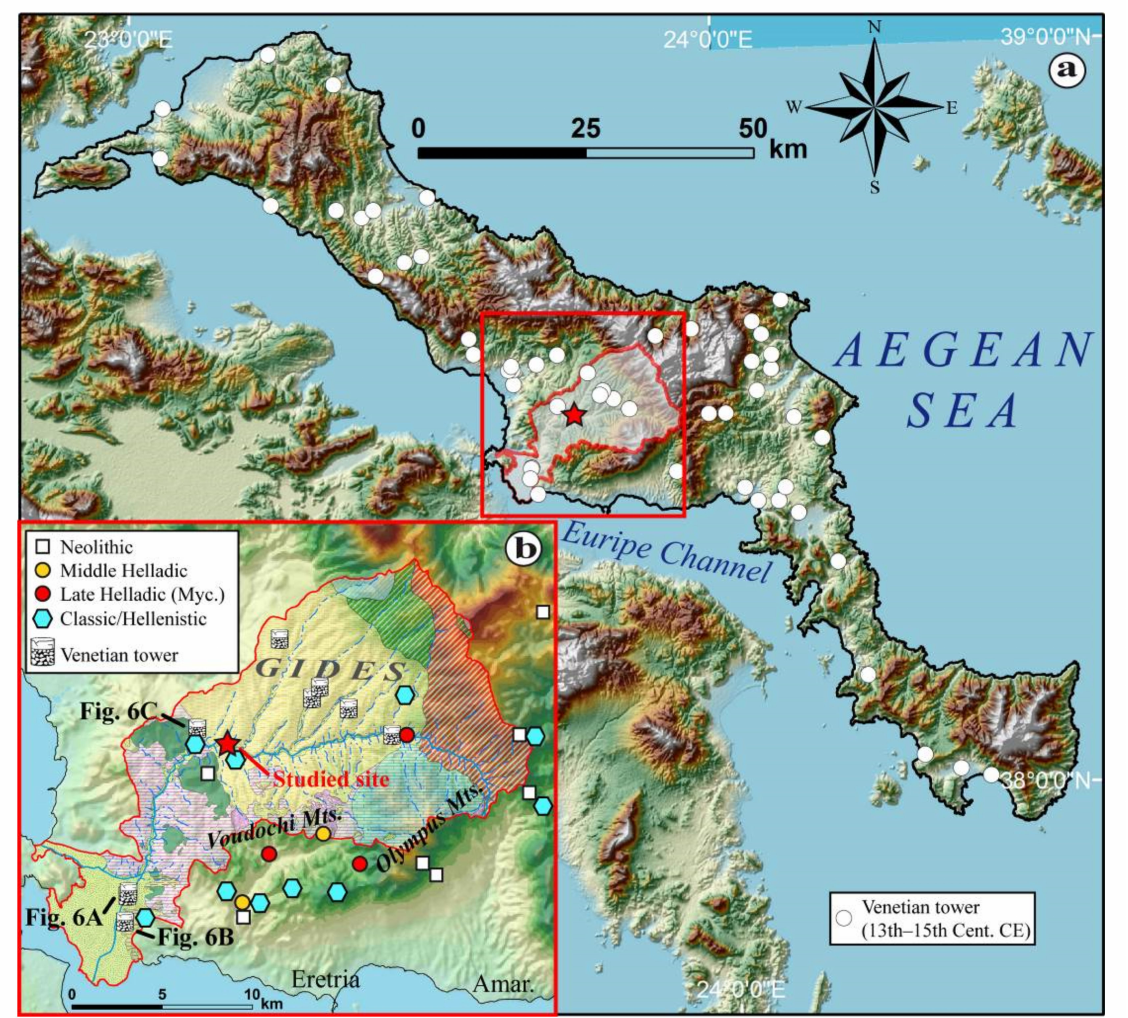
Figure 5. Archaeological map of the study area; ( a ) Location map of the Venetian towers (13th–15th Cent. CE) identified for Euboea Island [53]; ( b ) location map of the archaeological sites situated in the Lilas catchment and around